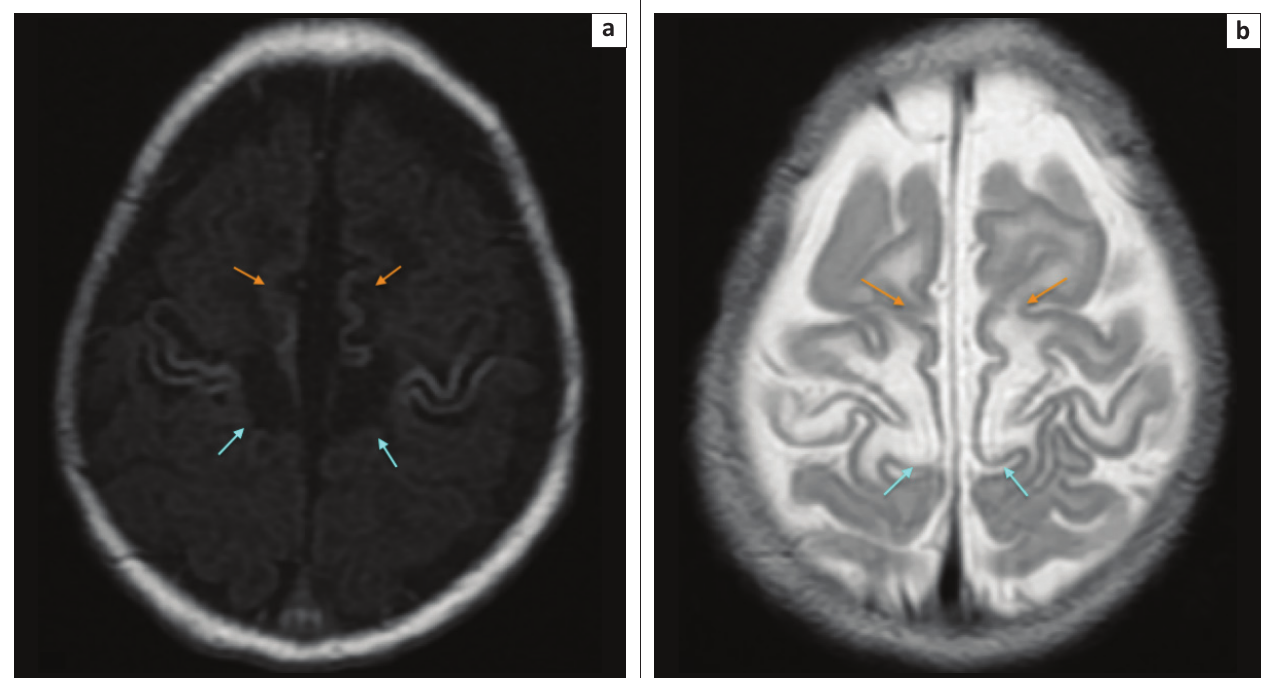
FIGURE 7: The same child as in Figure 6. Axial magnetic resonance imaging at the superior cerebral convexity demonstrating perirolandic cortical ribbon hyperintensity with T1 shortening (a) on both sides of the central sulcus and T2-weighted hyperintensity of the surrounding sensorimotor cortex (b). Note associated localised parasagittal cortex (orange arrows) and paracentral lobule (cyanide arrows)